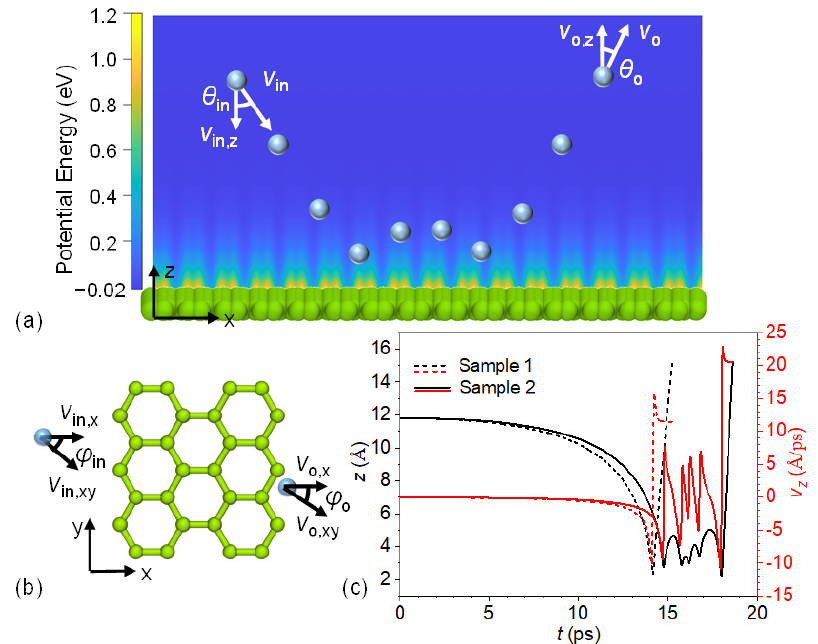
Figure 1. ( a ) An illustration of a sampling system composed of a helium atom (blue sphere) and monolayer graphene (green sphere layer). The multiple blue spheres illustrate one trajectory of a helium atom scattered on the graphene surface. The background shows the potential energy of the system relative to the case where the helium atom is 20 Å from the graphene surface. θ and V stand for the polar angle and the velocity of helium. The subscripts “in” and “o” denote the incident and scattered helium, respectively. ( b ) Top view of the helium–graphene system. φ denotes the azimuth angle, and the subscript “xy” represents the in-plane component. ( c ) Two characteristic examples of the scattering process of helium on monolayer graphene. The black curves are the distances of helium atoms from the top surface of the graphene, and the red curves are the normal velocity components of helium.